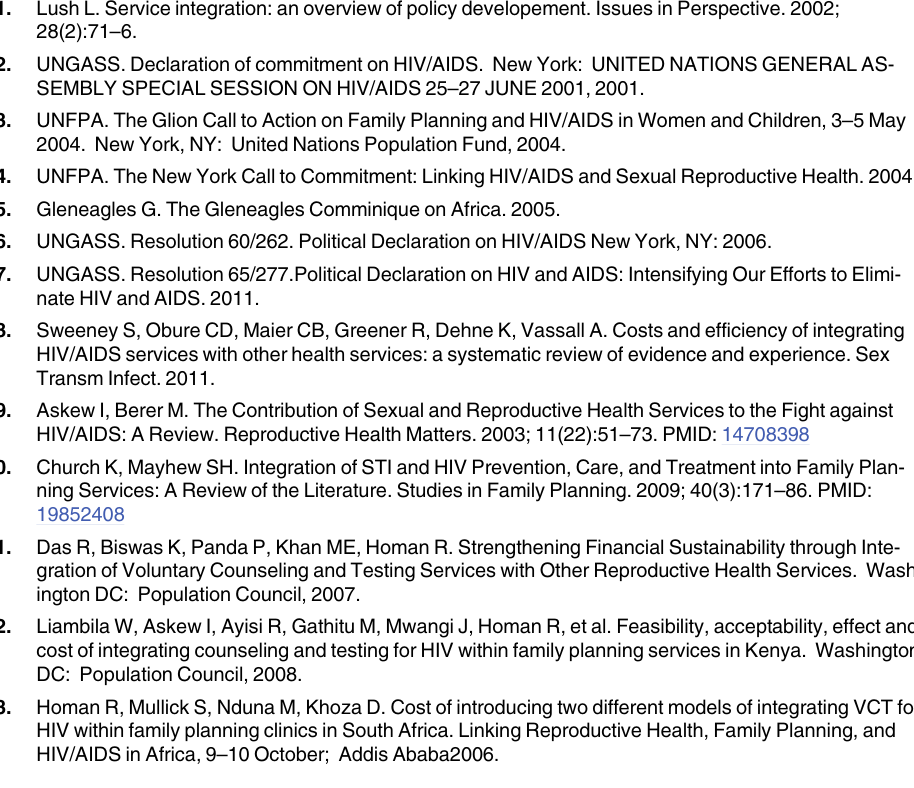
S1 Fig. Variation in mean cost per visit (cid:1) by service type. (cid:1) Mean cost per visit includes drugs, diagnostics and supplies. S1 Table. Breakdown of HIV and SRH Service average visits and average costs (Int $ 2013) by country and health facility